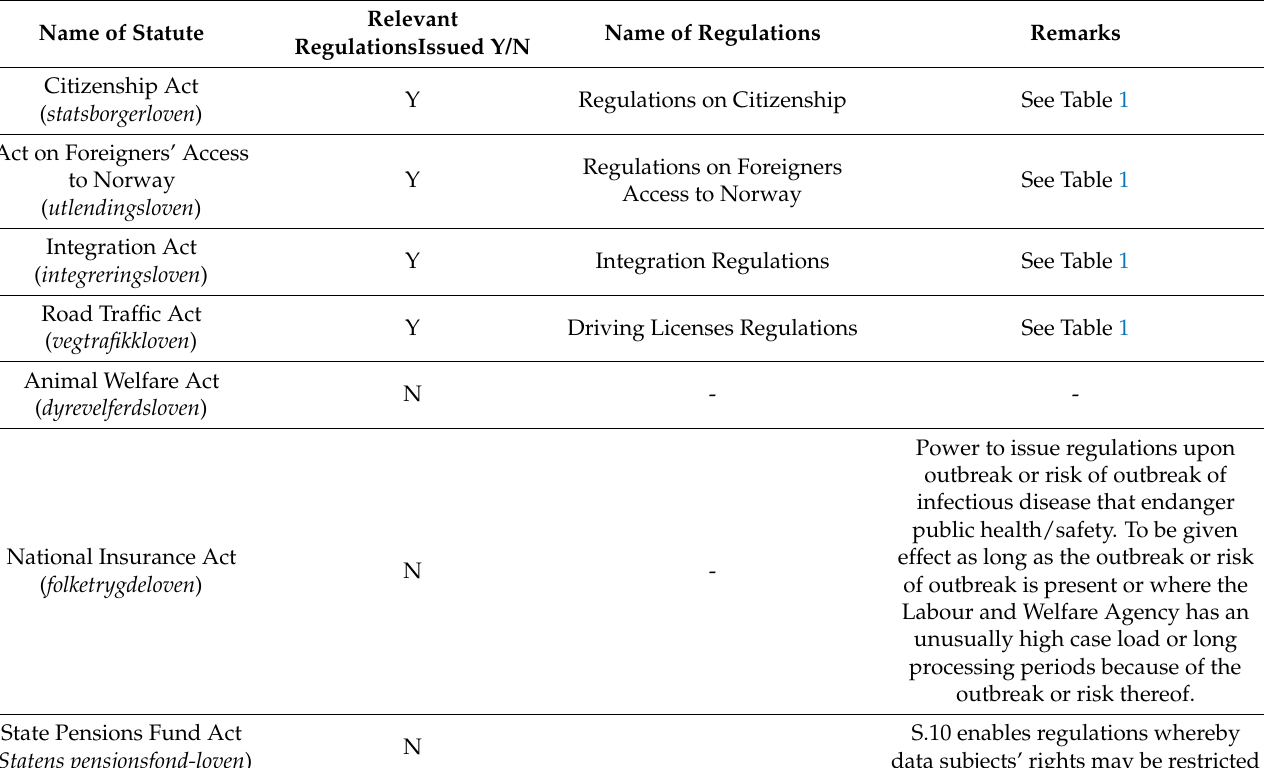
Table 2. Statutes which solely contain an enabling